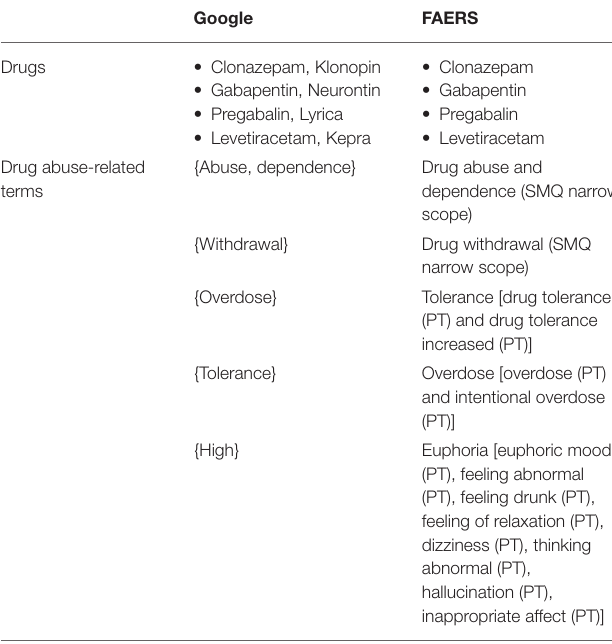
TABLE 1 | Drug names and drug abuse-related